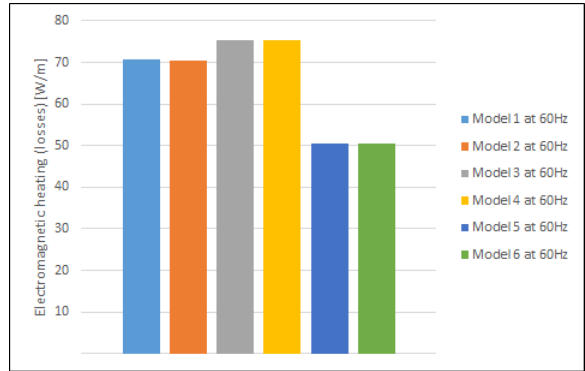
Figure 13. Electromagnetic losses on all models at 60 Hz.